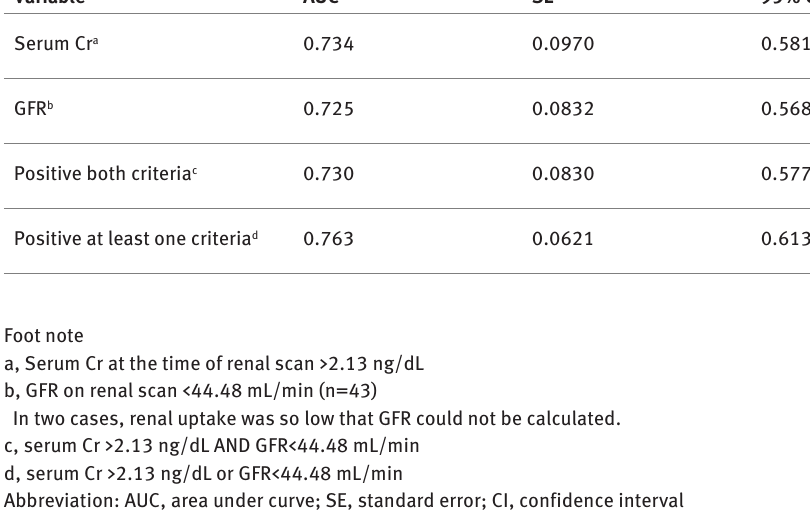
Table 3: ROC analysis to predict graft failure